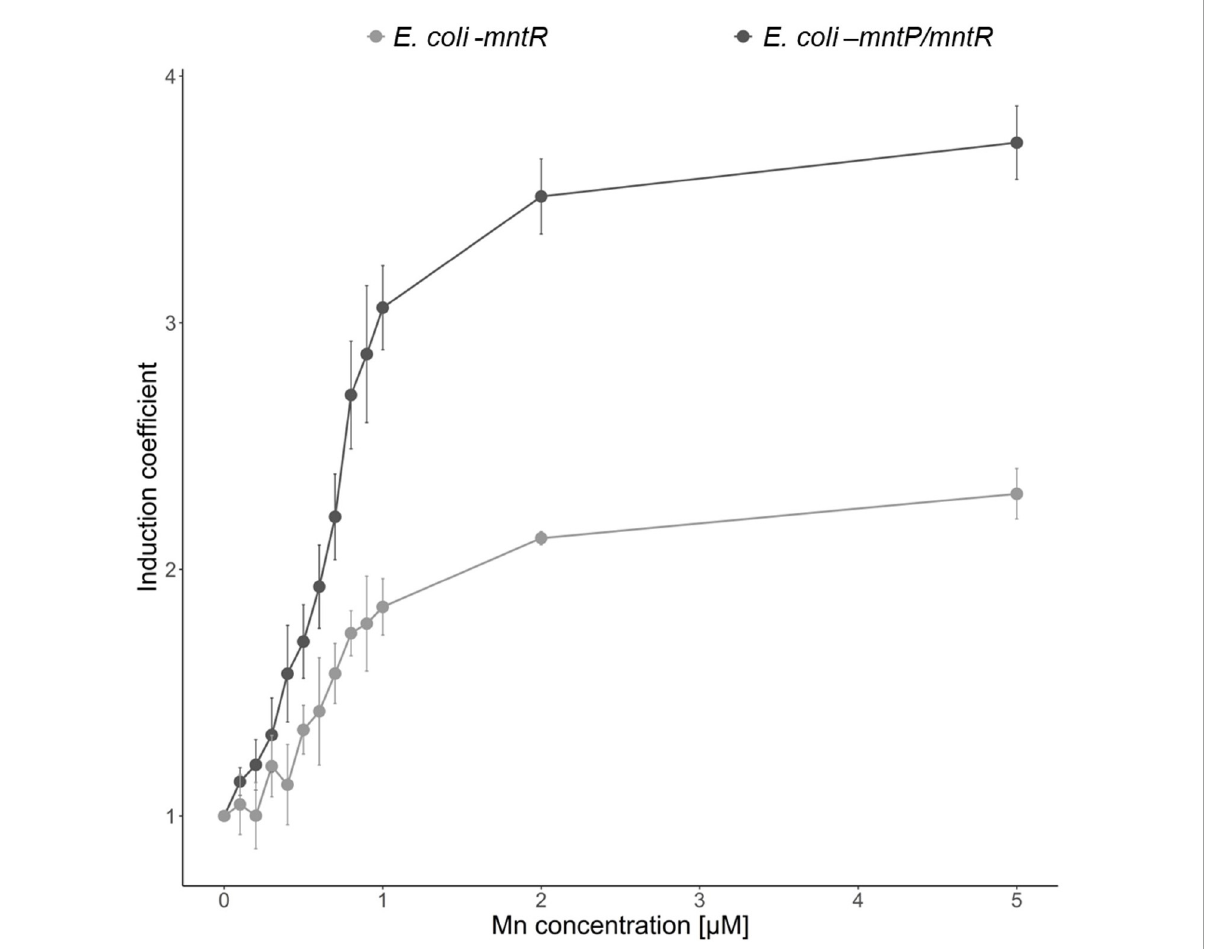
FIGURE5 Effects of MntP on Mn(II) sensitivity of Escherichia coli cell-based biosensors. E. coli-mntR (gray) and E. coli-mntR/mntP (black) harboring pMntS-eGFP/pCDF-MntR were exposed to Mn(II), and the corresponding fluorescence signals were compared after 2 h. The data was obtained from more than three times of replicated